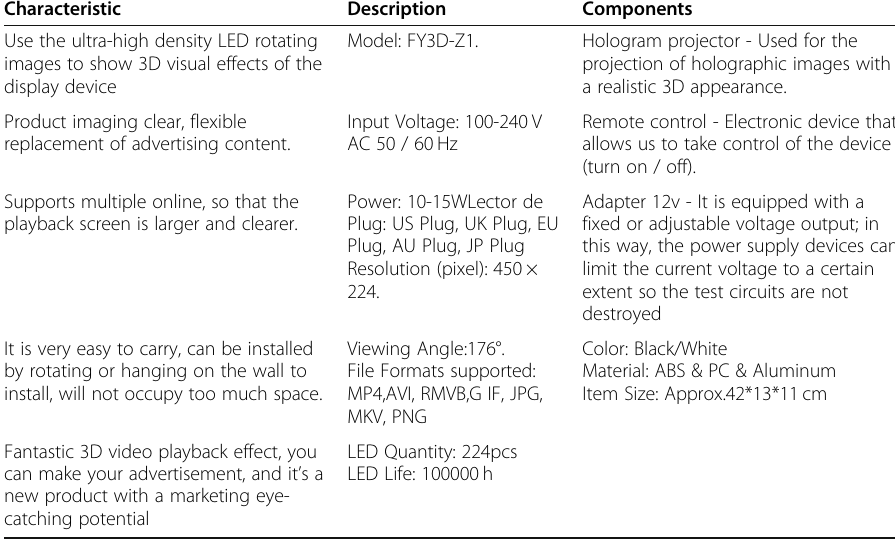
Table 1 Holographic display